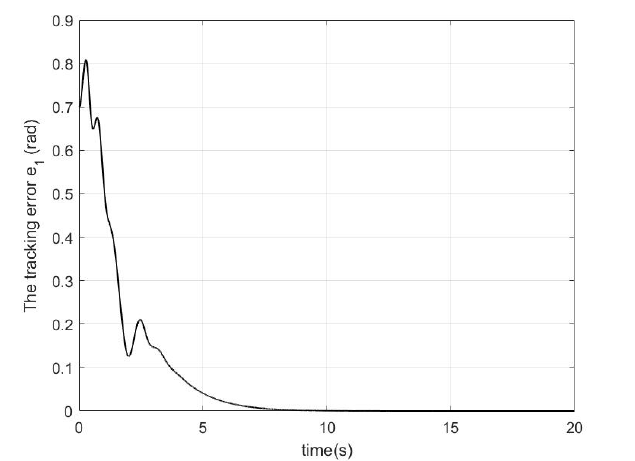
Figure 1. The performance of the tracking error e 1 in Case